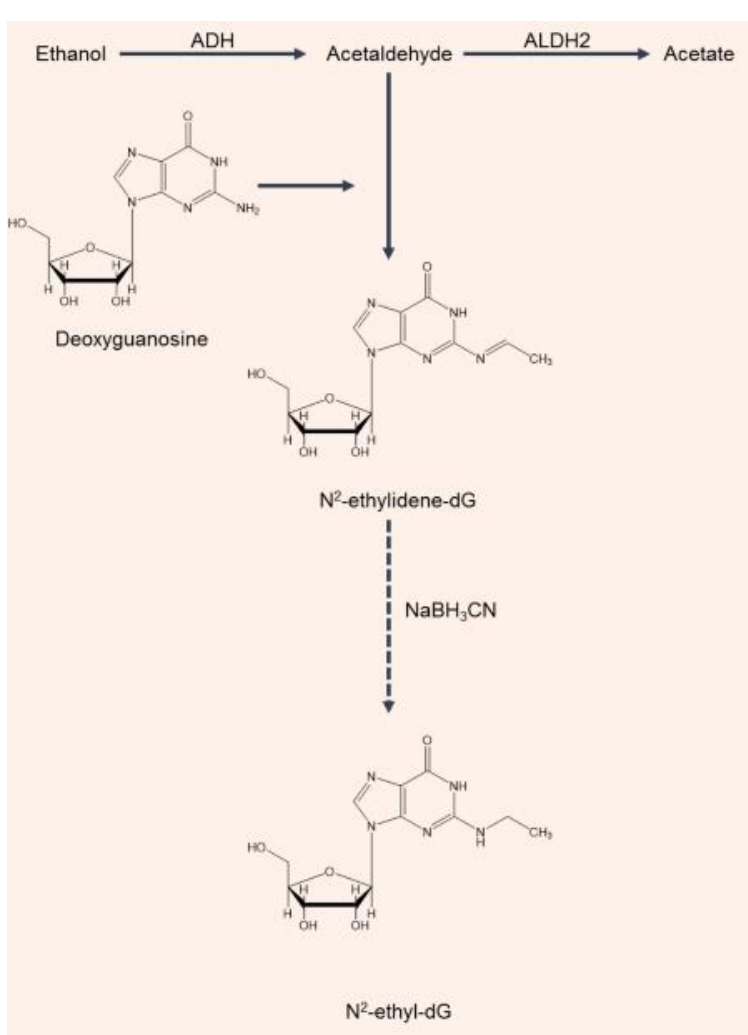
Figure 2. Formation of the N2-ethylidene-dG adduct and the N2-ethyl-dG adduct due to acetaldehyde production from ethanol. Acetaldehyde can interact with deoxyguanosine (dG) to form a Schiff base N2-ethylidene-dG. During the reduction step, the unstable N2-ethylidene-dG is expected to be converted to the stable N2-ethyl-dG.